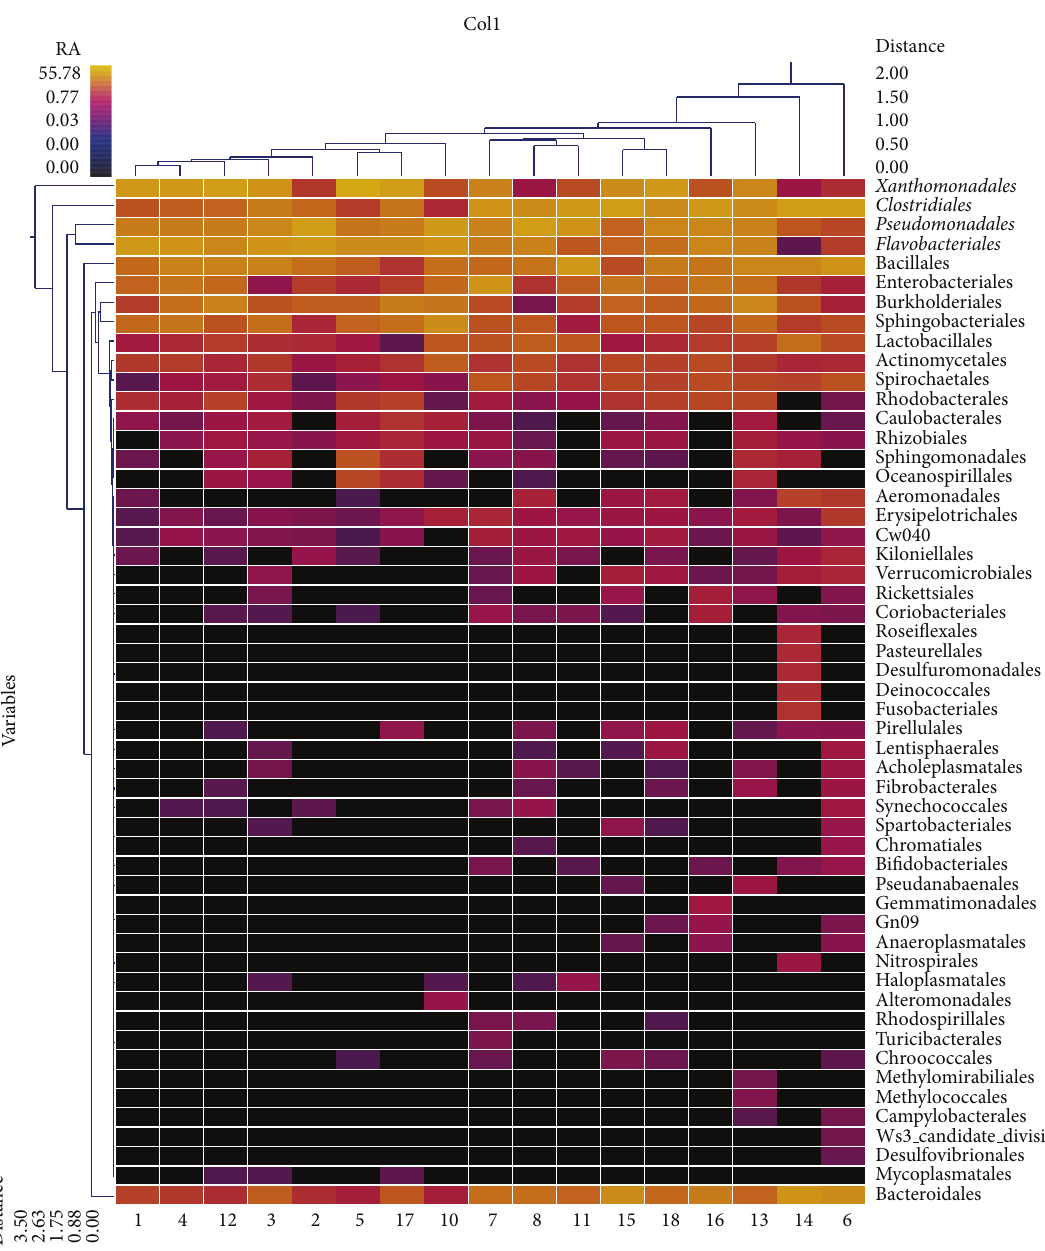
Figure 6: Thermal double dendrogram of the 53 most abundant bacterial genera in the hindgut of various levels of pine bark (PB) diets from a common cohort of 17 meat goats. Clustering in the 𝑌 direction is indicative of abundance, not phylogenetic similarity. RA = relative abundance; 0% PB (control) = tag number 1, 2, 3, 4, 5, and 6; 15% PB = tag number 7, 8, 10, 11, and 12; 30% PB = tag number 13, 14, 15, 16, 17, and